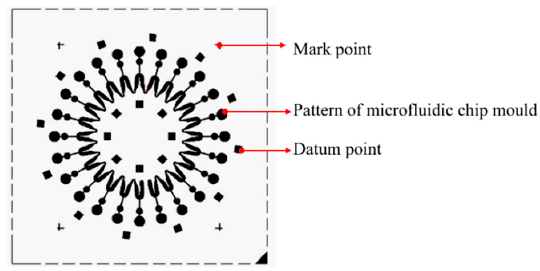
Figure 1. Photomask of the microfluidic chip mold.